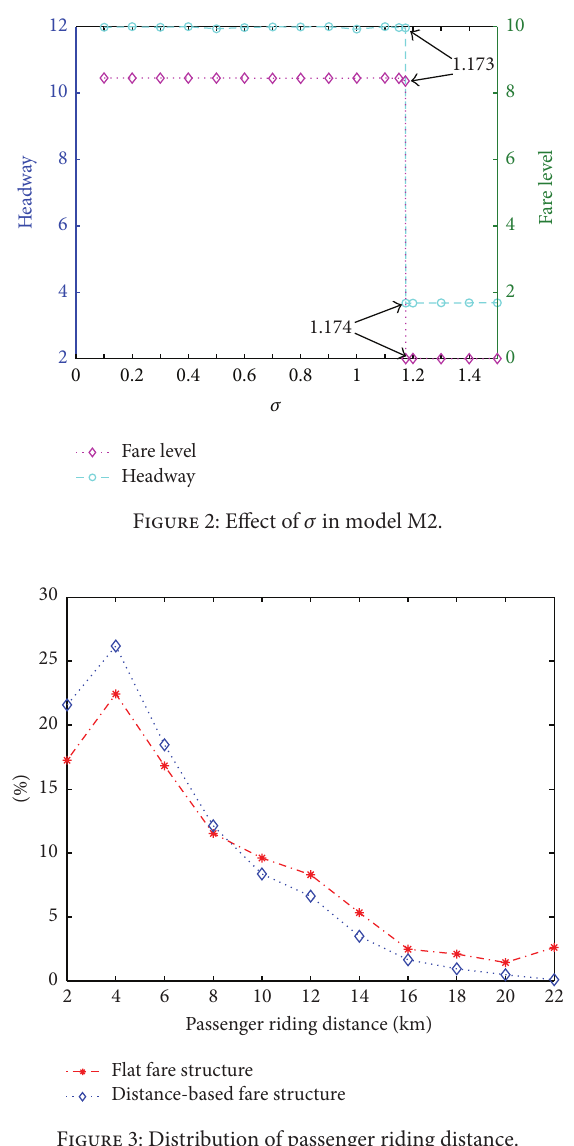
Figure 3: Distribution of passenger riding